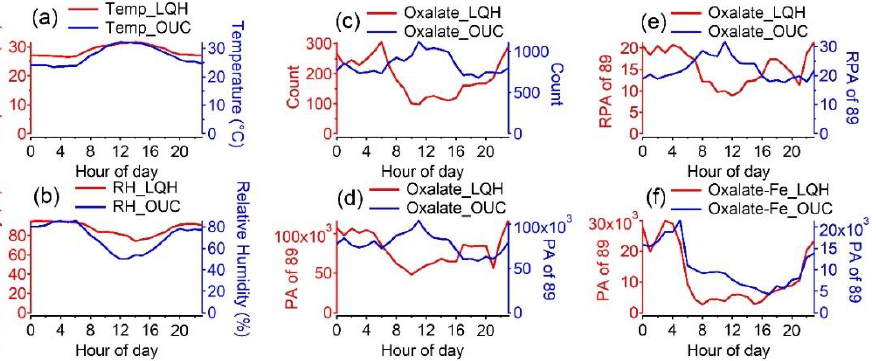
Figure 3. Diurnal variations in meteorological parameters (temperature ( a ); relative humidity, RH ( b )) and particle number ( c ), PA ( d ), and RPA ( e ) of oxalate ( m / z −8 9) in oxalate-containing particles ( b )) and particle number ( c ), PA ( d ), and RPA ( e ) of oxalate ( m / z − 89) in oxalate-containing particles and PA of oxalate in oxalate ‐ Fe particles ( f ). and PA of oxalate in oxalate-Fe particles ( f